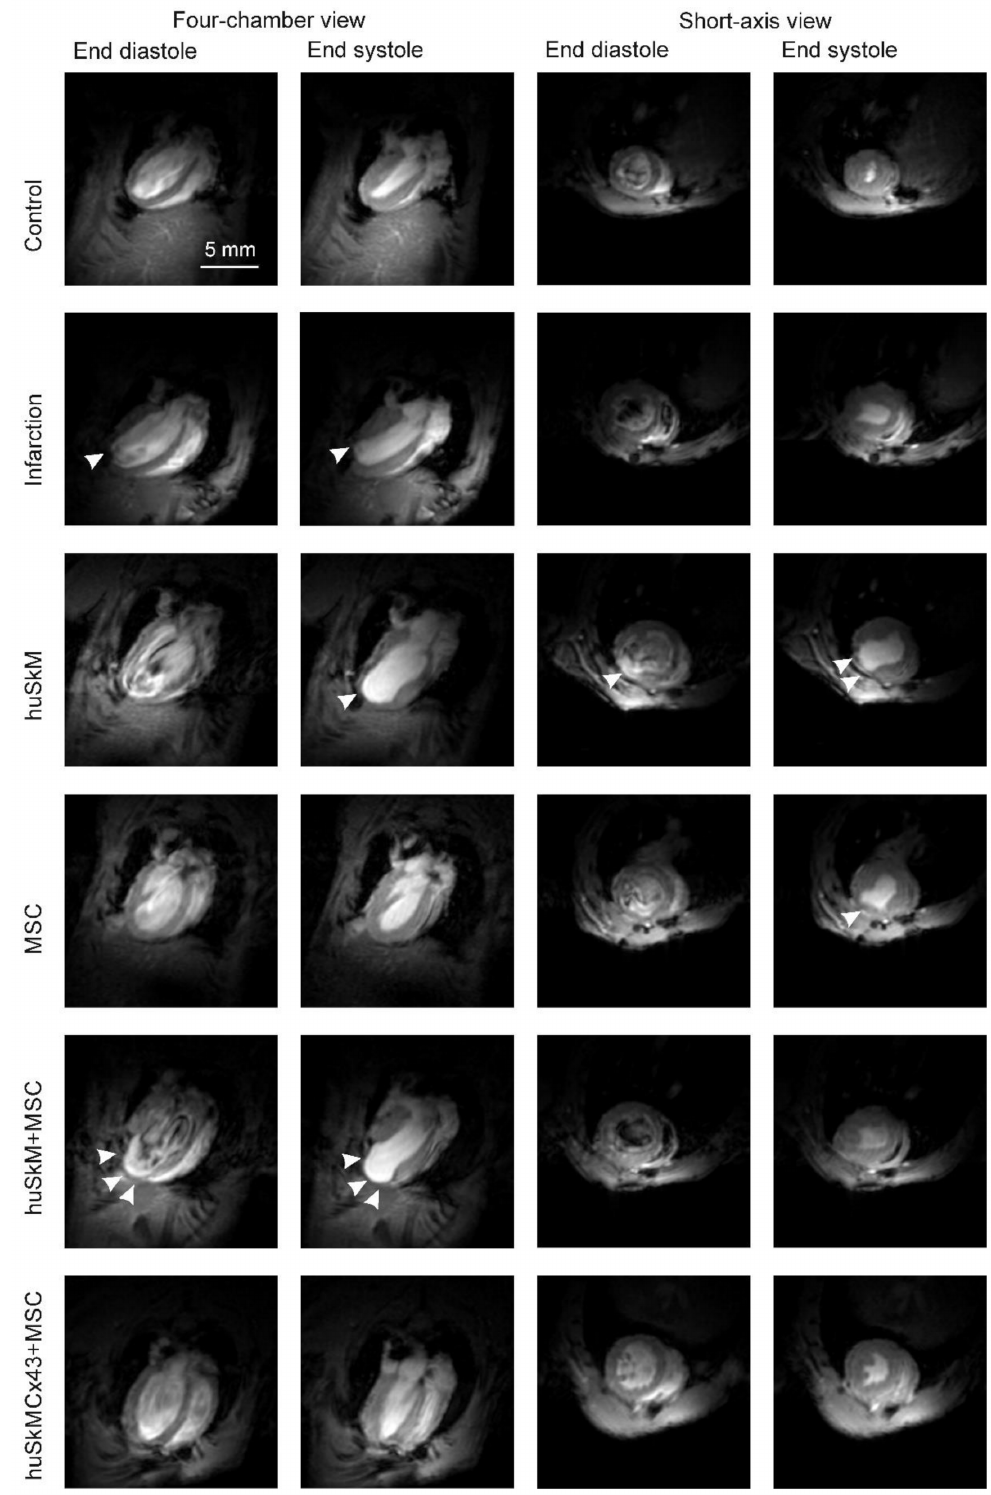
Figure 8. Representative MR images of control hearts (no interventions), post-infarction hearts, and healthy hearts after huSkM, MSCs, huSkM + MSC or huSkMCx43 + MSC cell interventions. The first two columns represent the 4-chamber view (end-diastole is the first column and end-systole is the second column); the next two columns represent the short-axis view (end-diastole is the third column and end-systole is the fourth column). The infarct area is indicated by